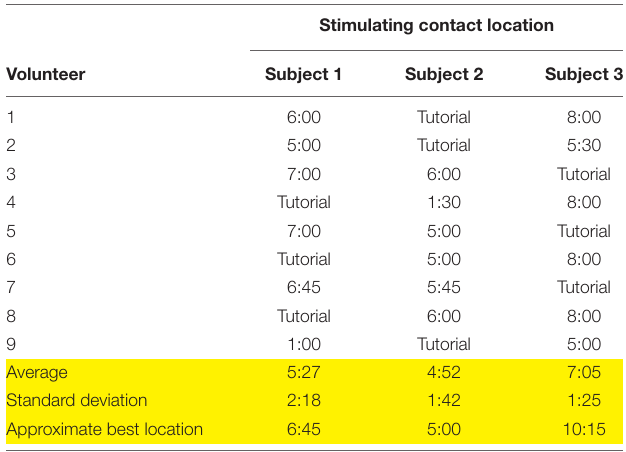
TABLE 1 | Responses for the location of the stimulating contact from each volunteer, based on the subject videos provided. Stimulating contact